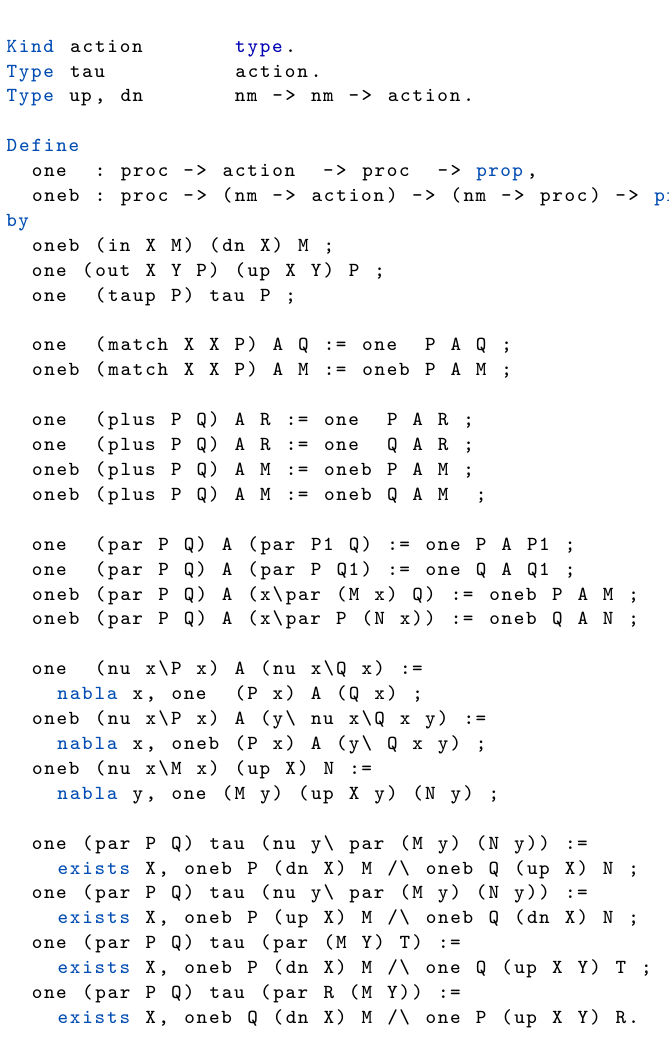
Fig. 3: The specification of actions and the one-step